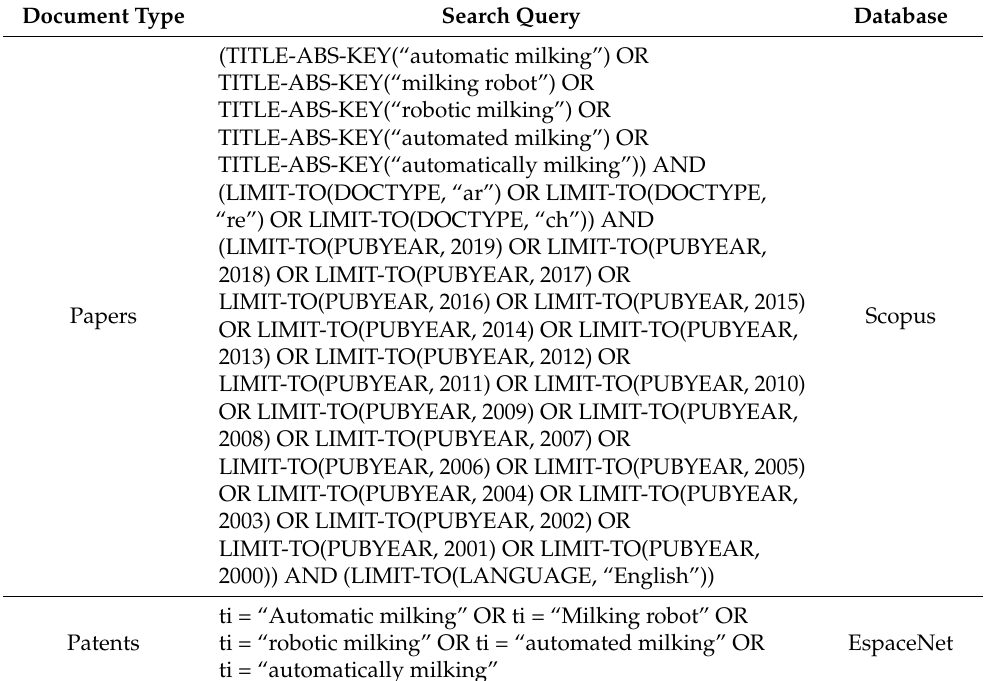
Table 1. The custom queries used for documents extraction (ar = article; re = review; ch = book chapter). Document